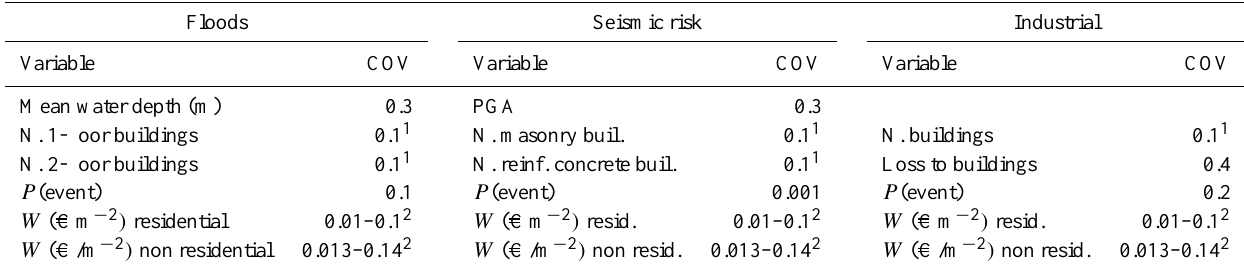
Table 2. Uncertain variables, and values for coefficients of variation (COV) adopted in the analysis. P (event) is the annual exceeding probability of the scenario, W the economic